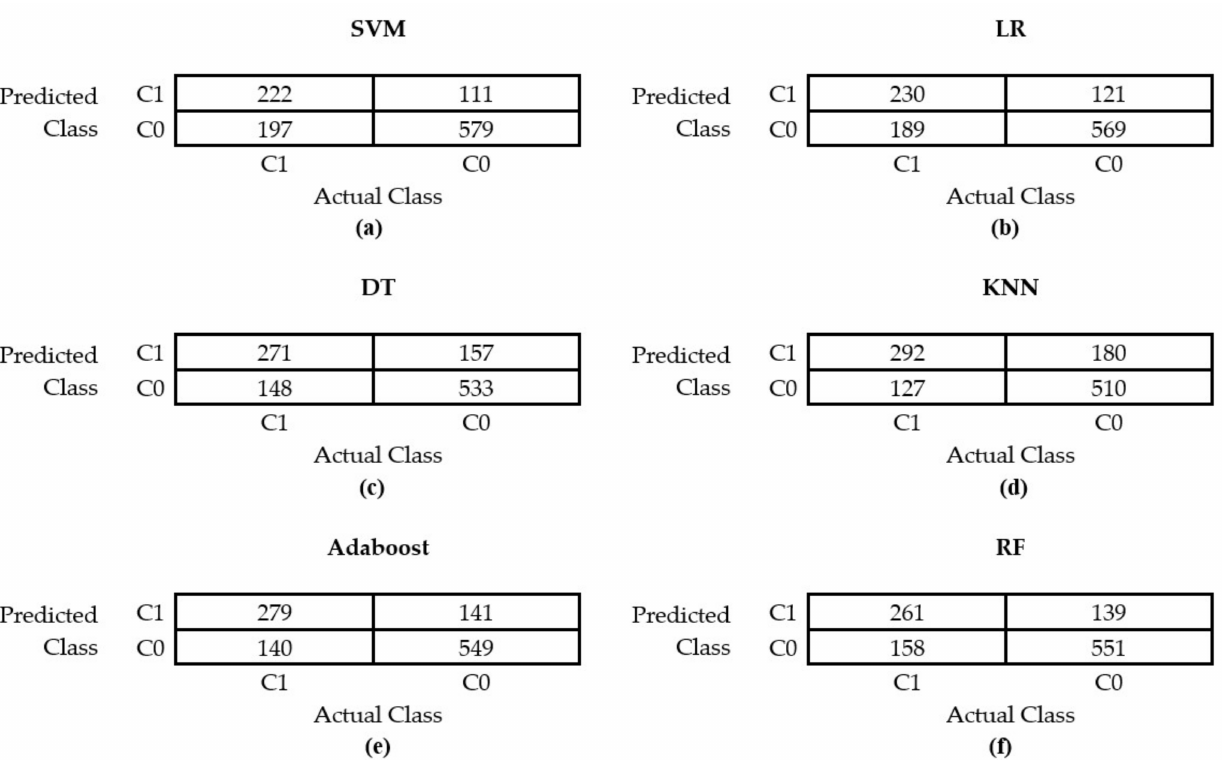
Figure 2. Confusion matrixes of the six competing ML models: ( a ) SVM, ( b ) LR, ( c ) DT, ( d ) KNN, ( e ) Adaboost and ( f ) RF.